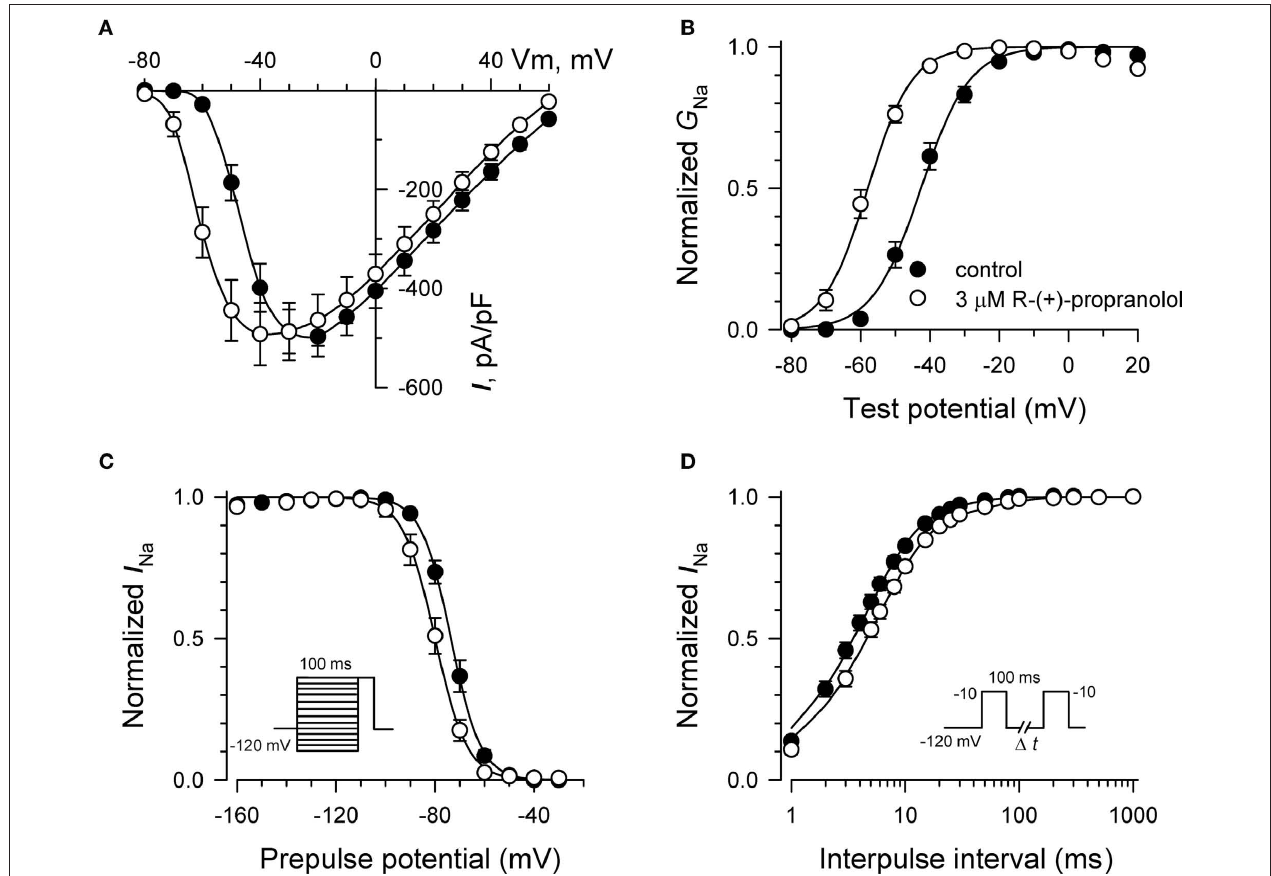
channel availability (“steady-state inactivation”) in the absence and presence Figure 7 | Biophysical effects of propranolol on Na 1.5-F1760A channels. V of drug measured using a two-pulse protocol illustrated in the inset. (D) Effect (A) Current–voltage relationships in the absence and presence of 3 μM of (R)-( + )-propranolol on recovery from inactivation (holding potential R-( + )-propranolol. Peak current amplitudes were elicited from a holding potential of − 120 mV to various test potentials then normalized to cell − 120 mV). Fit parameters for data in (B–D) are provided in Table 2 , and lines in (B,C) represent Boltzmann fits. Each point represents mean ± SEM from capacitance. (B) Conductance–voltage relationship in the absence and 7 to 14 presence of 3 μM R-( + )-propranolol. (C) Voltage-dependence of sodium